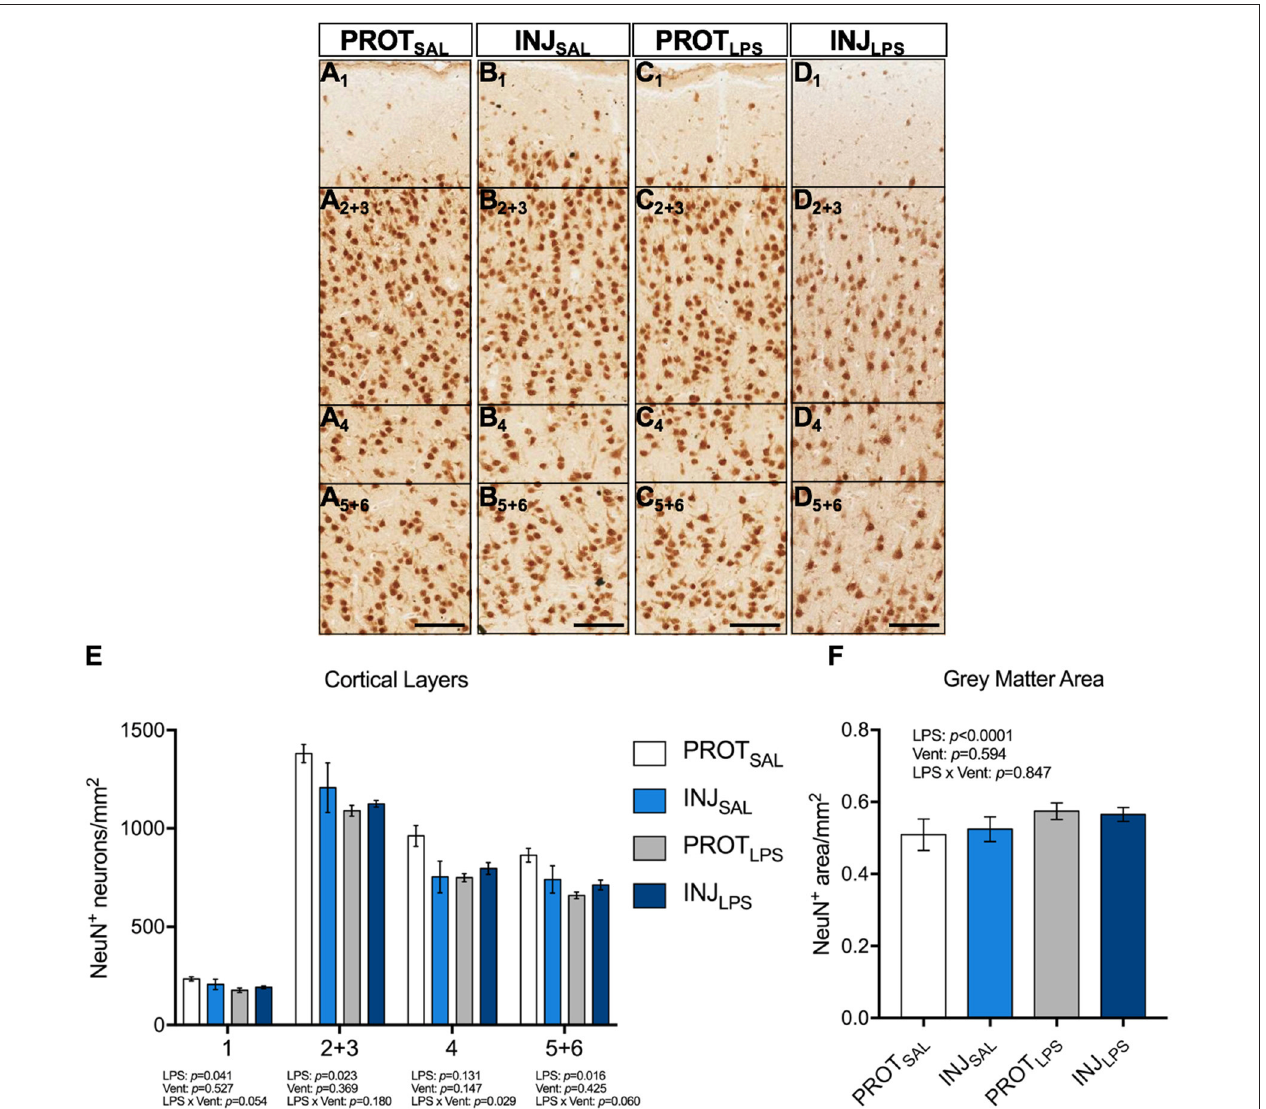
FIGURE 3 | LPS exposure, irrespective of ventilation strategy leads to neuronal loss in the cortical layers and is associated with changes in gray matter area. Representative images of NeuN + neurons in the cortical layers of the gray matter (A 1 -D 5 + 6 ) . LPS exposure induced significant neuronal loss throughout all cortical layers (except 4) (E) . Gray matter area was significantly higher in the LPS-treated groups ( p < 0.0001) when compared to the saline-treated lambs, whilst ventilation had no effect (F) .Magnification = 2x, scale bar = 20 µ m. PROT SAL , N = 5; PROT LPS , N = 6; INJ SAL , N = 6; and INJ LPS , N =